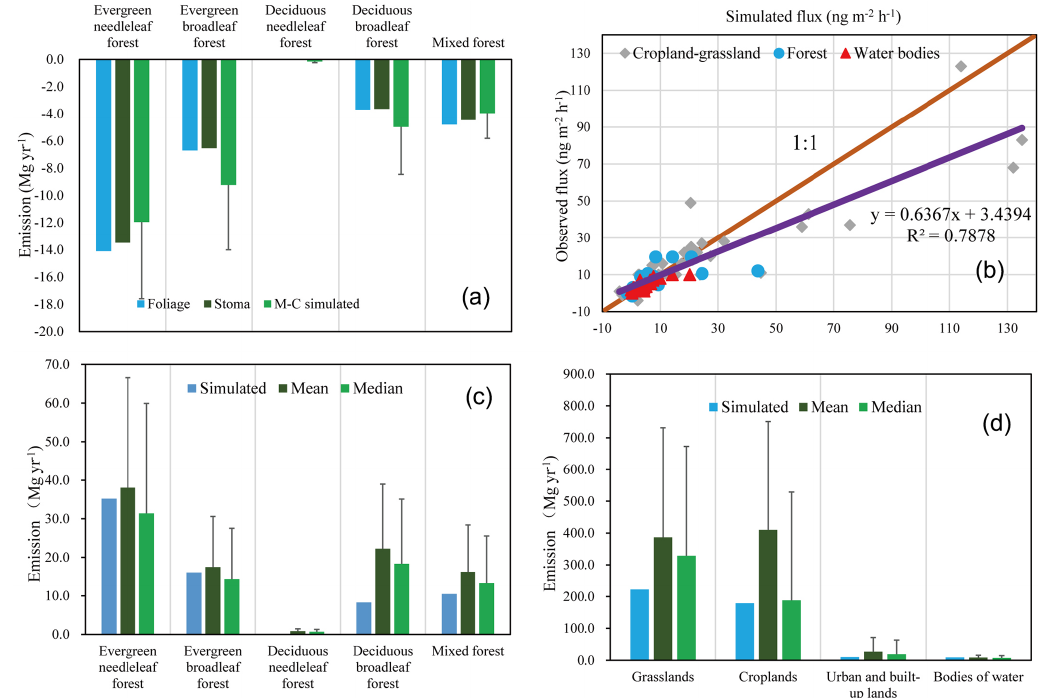
Figure 8. Model verification: (a) model estimates of Hg 0 uptake by foliage (which include the uptake by stoma and the re-emission from cuticle) and by stoma, compared to the estimate (mean and 95% confidence interval) of Hg 0 uptake using a Monte Carlo (M-C) simulation of the observational data; (b) scatter plot of the observed fluxes vs. simulated fluxes for different land uses (the flux observations are described in detailed in Table S2), (c) comparison between simulated exchange and measured exchange over soil under canopy, and (d) comparison between simulated exchange and measured exchange over grasslands, cropland, and water surface. The mean and median of Fig. 8c and b are based on the filed data from peer-reviewed literature ( n = 19 for forests; n = 12 for grasslands; n = 42 for croplands; n = 51 for water bodies). Note that the exchange over deciduous needleleaf forests in (a) is small because of the small forest